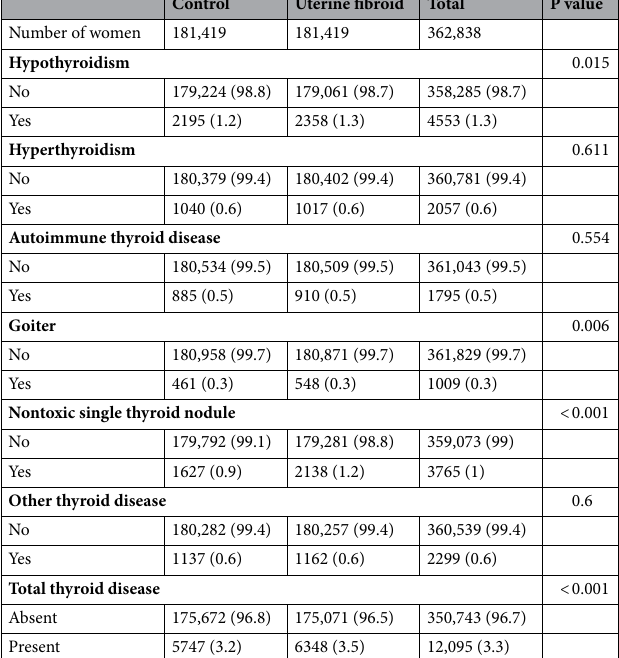
Table 2. The cases of thyroid disease among women with uterine fibroid or controls in the HIRA claim data (1:1 matching). HIRA, Health Insurance Review & Assessment Service. Data are expressed as the number (%).